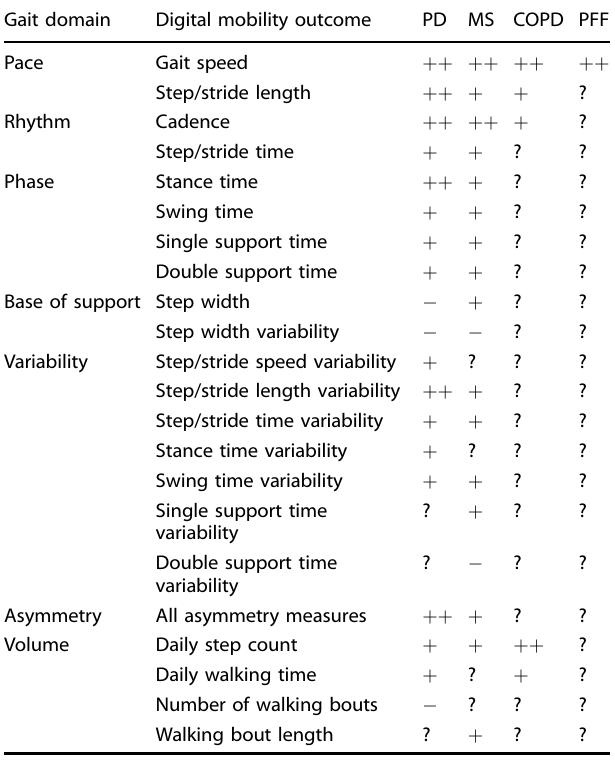
Fig. 7 Ecological validity of DMOs in Parkinson ’ s disease: DMOs collected in clinical vs real-world environments. Data are presented as: Number of studies with statistically signi fi cant associations between DMOs and measures of lower-extremity function/Total studies (%). DMOs known to be highly intercorrelated were grouped (i.e., step length and stride length), and all DMOs were organized according to previously established domains of gait. *Proportion of studies exceeds the expected false-positive rate as determined by Bernoulli hypothesis testing and Benjamini – Hochberg adjustment. Table 2. Qualitative appraisal of existing